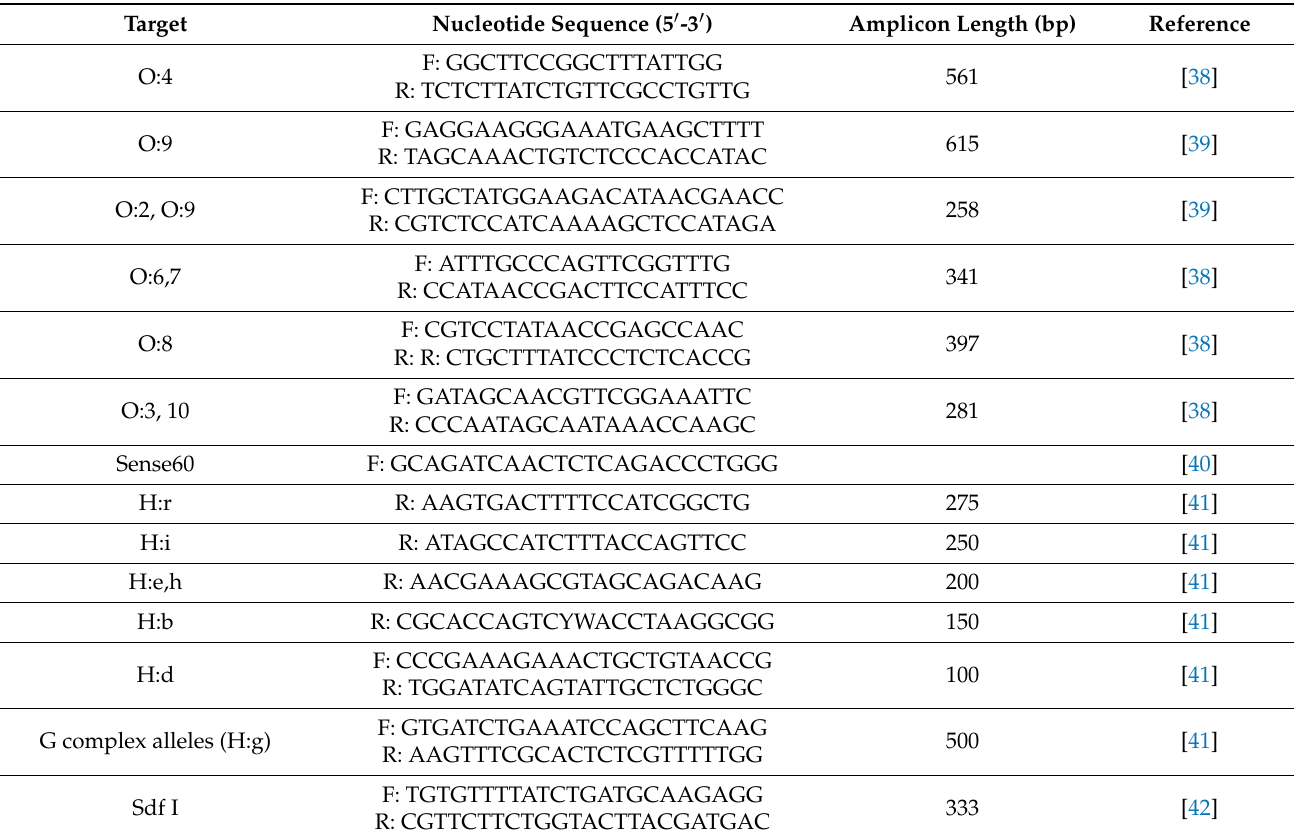
Table 4. Targets and primers used in molecular characterization of S. enterica